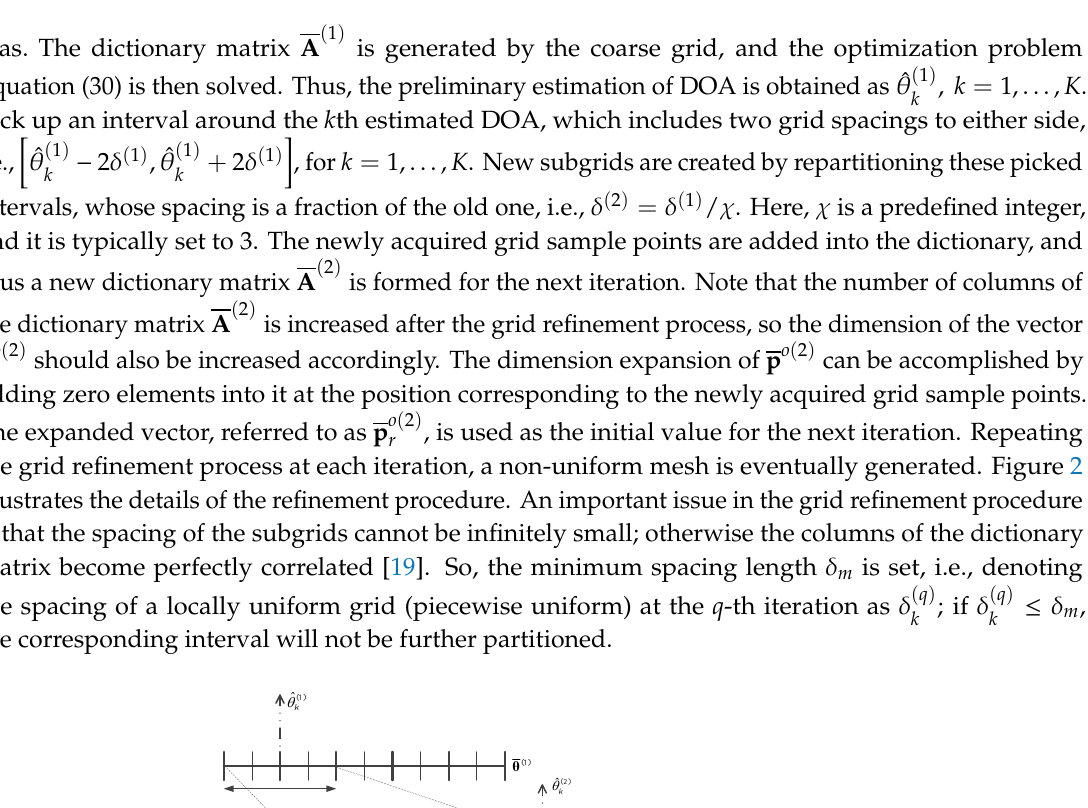
( q ) k K q Q  = = is the estimated DOA of , k = 1, ... K , q = 1, ... , Q is the estimated DOA of k k ( q ) ( q )  at the q -th iteration. at the q -th iteration. stands for the gird around ˆ θ k k